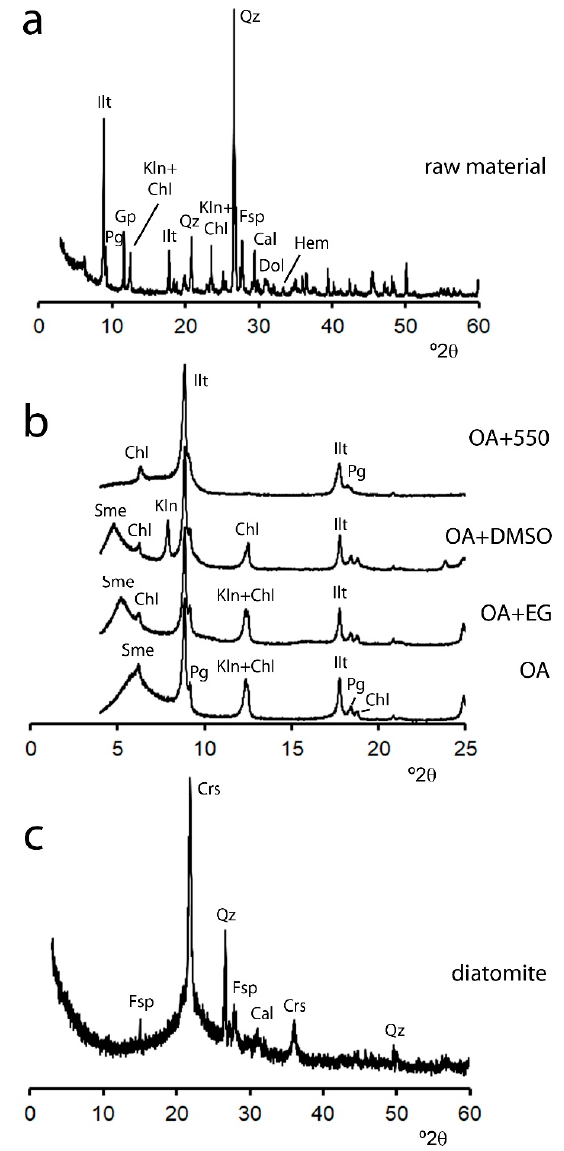
Figure 1. X ray diffraction patterns for the raw material from Jun ( a ), oriented aggregates from the clay fraction ( b ) and calcined diatomite sludge ( c ). Oriented aggregates are: Air-dried (OA), solvated with ethylene-glycol (OA + EG), solvated with dimethyl-sulfoxide (OA + DMSO), heated at 550 °C (OA + 550). Legend (mineral symbols after Whitney and Evans [55]): Qz = quartz, Ilt = illite; Gp = gypsum; Cal = calcite; Dol = dolomite; Hem = hematite; Chl = chlorite; Kln = kaolinite; Fsp = feldspar/plagioclase (in general); Sme = smectite; Pg = paragonite; Crs = cristobalite.